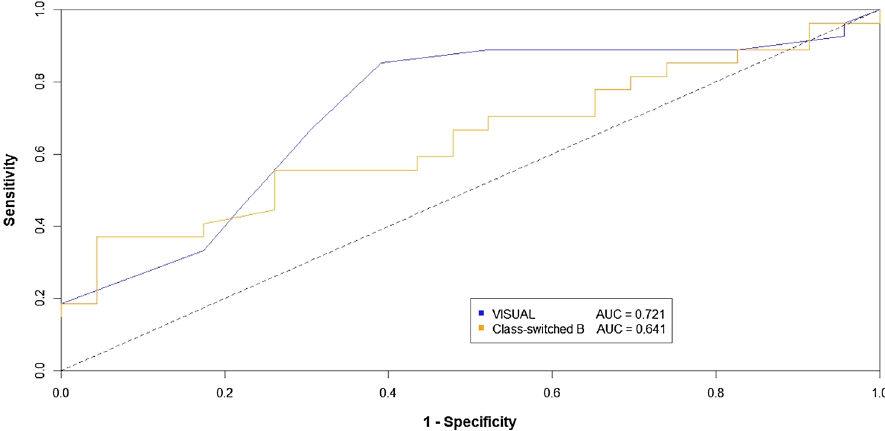
Figure 2. Receiver operating characteristic (ROC) curves for VISUAL versus isolated smB lymphocytes determination as a predictor of severity manifestations in CVID patients. Abbreviation: AUC, area under the curve. VISUAL showed significantly higher sensitivity (85% vs 55%, p = 0.01) and negative predictive value (77% vs 58%, respectively), while similar positive predictive value (72% vs 71%, respectively) and specificity (60% vs 73%, respectively) between both tests. The AUC obtained using the VISUAL score was superior to that derived using the isolated determination of smB lymphocytes, without statistical significance (AUC 0.721 versus 0.641).